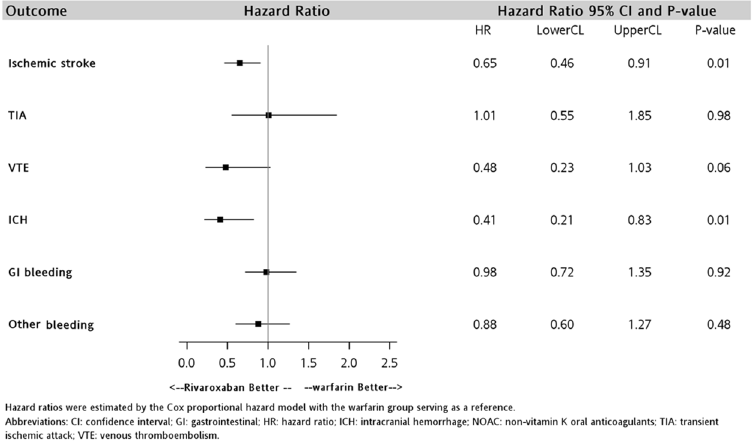
Figure 4. Hazard ratios comparing effectiveness and safety outcomes of rivaroxaban use in patients aged at least 80